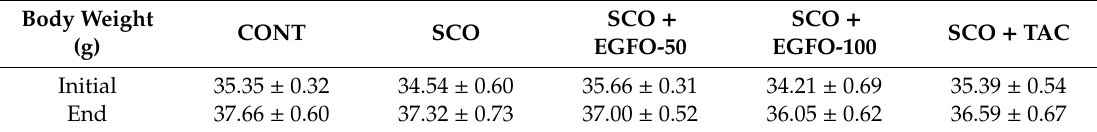
Table 1. Experimental body weight changes.